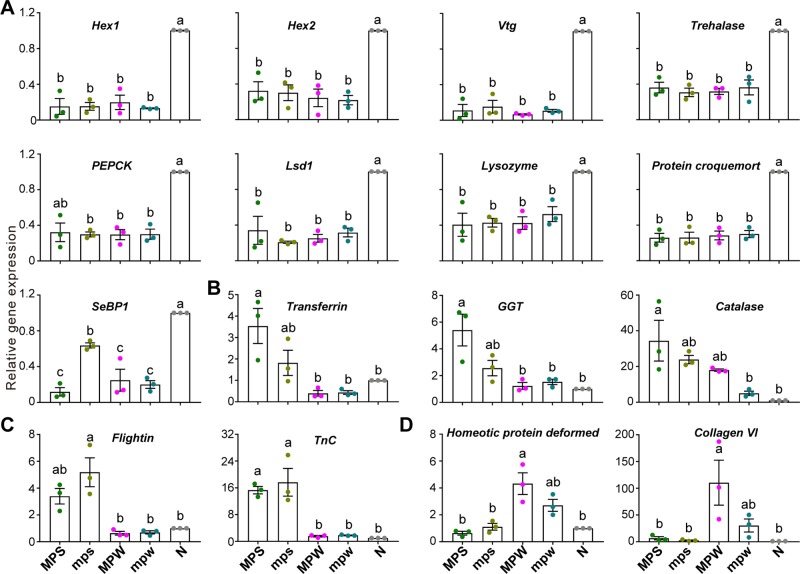
Validation of the 16 differentially expressed genes. RT-qPCR validation of the gene expression of (A) nine nymph-biased genes associated with caste differentiation, reproduction, energy metabolism, immune and detoxification, (B) three major presoldier-biased genes associated with immunity and antioxidation, (C) two presoldier-biased genes associated with muscle development, and (D) two preworker-biased genes associated with morphological development and muscle development. Error bars represent the mean value ± S.E.M. Different lowercase letters over the bars denote significant differences (P < 0.05). N, nymphs; MPS, major presoldiers; mps, minor presoldiers; MPW, major preworkers; mpw, minor preworkers.